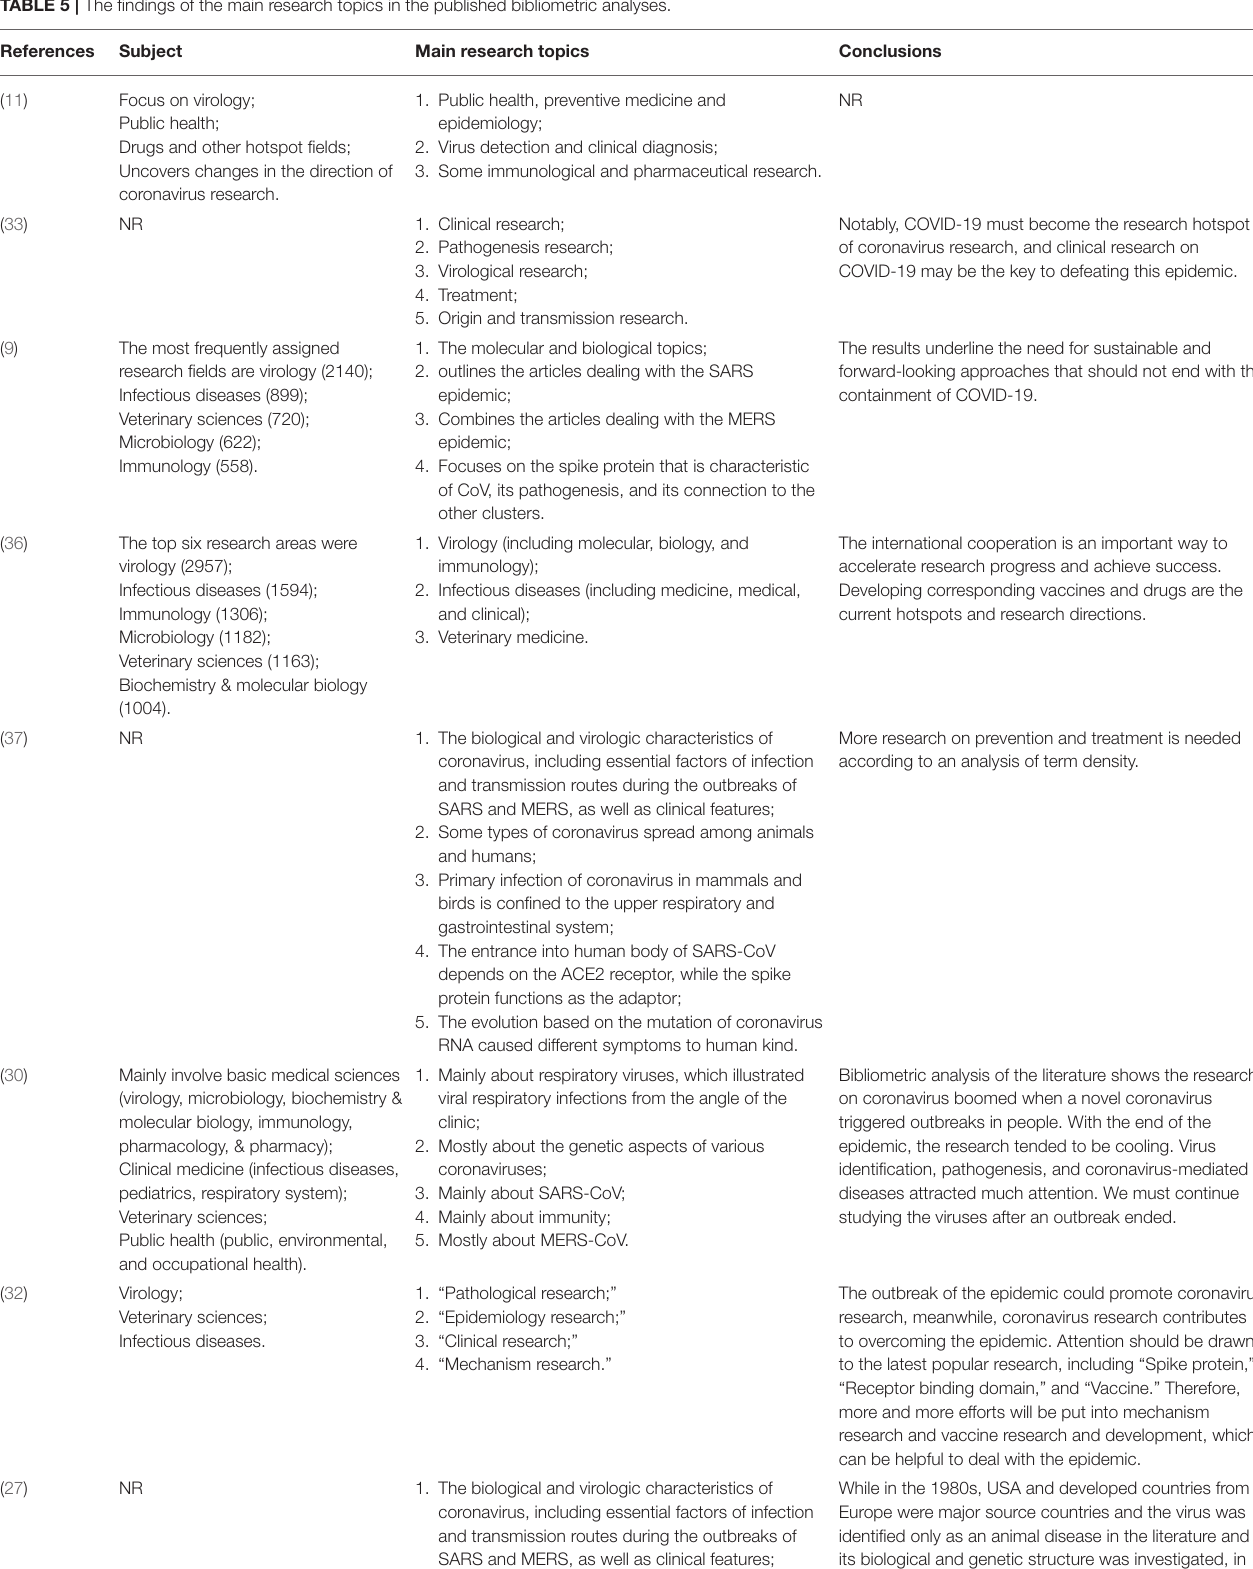
TABLE 5 | The findings of the main research topics in the published bibliometric